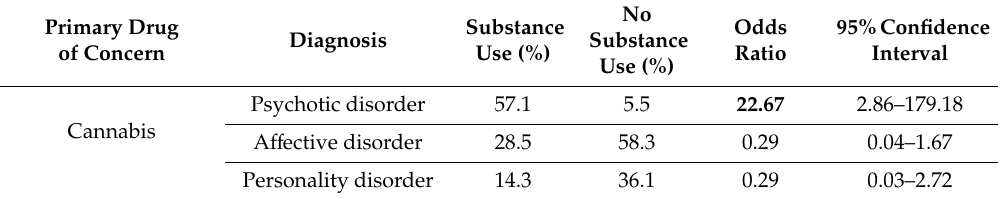
Table 2. Substance abuse by co-occurrent psychiatric disorder. Unadjusted odds ratios and 95% confidence intervals are presented. Significant results are marked in